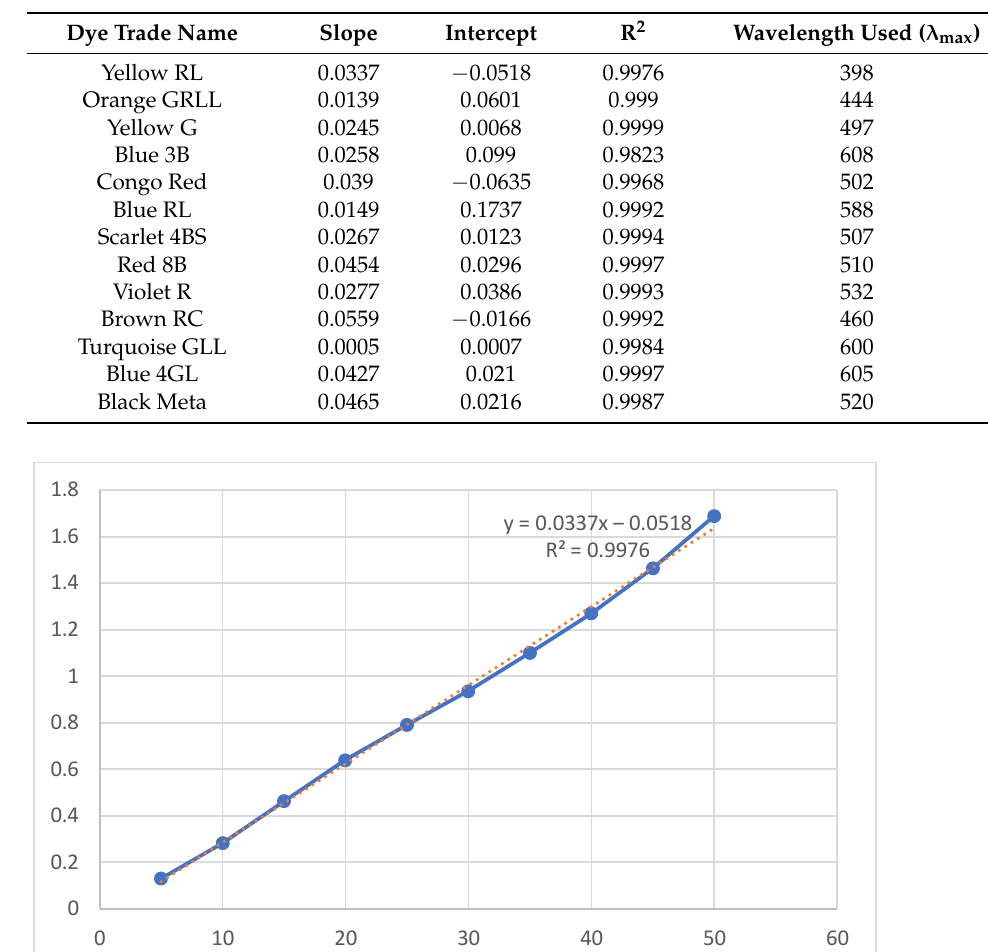
Table 3. Calibration curves data.